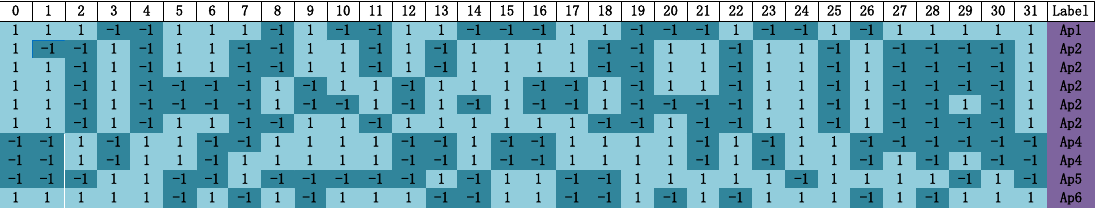
Figure 6. The 32-bit encoding results of DPSH method on PLAID